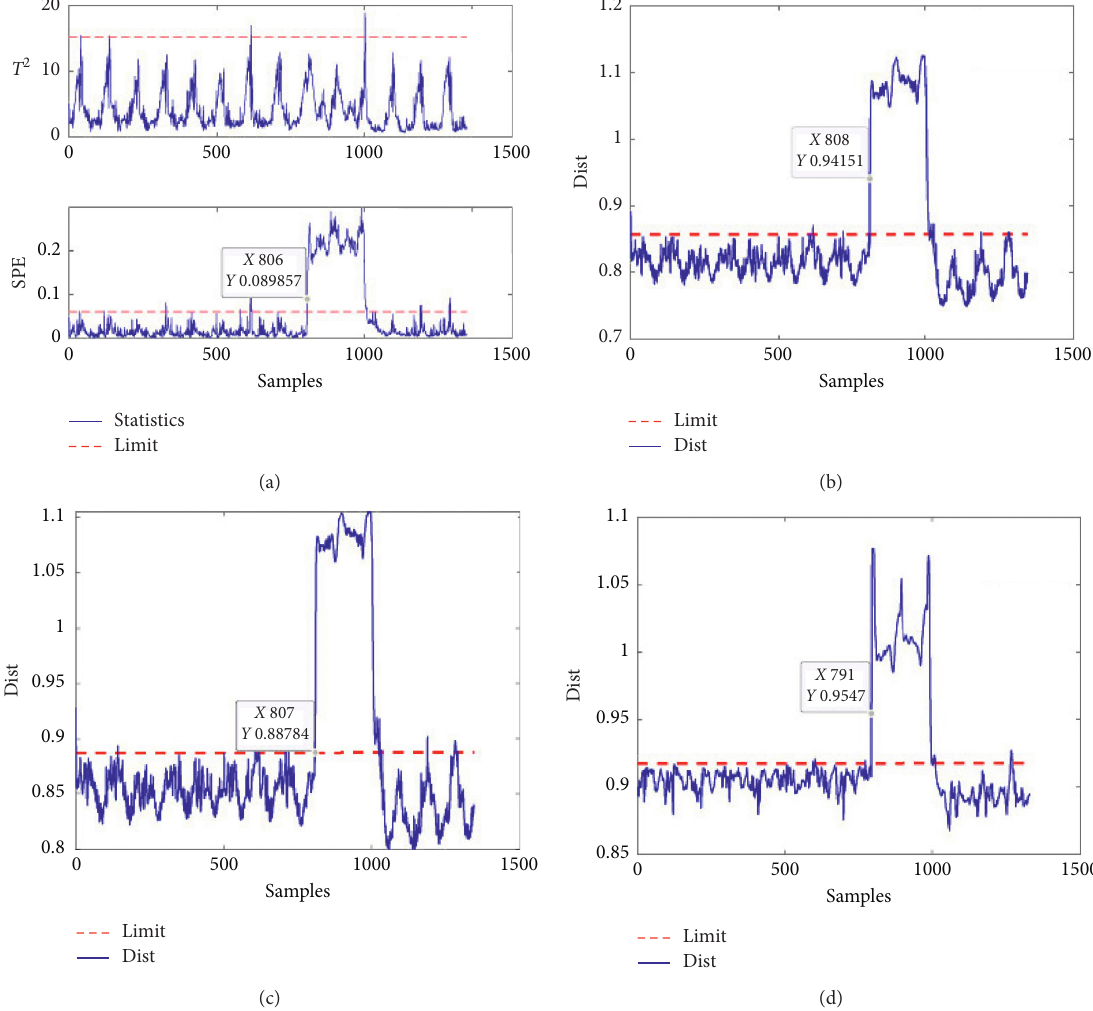
Figure 8: Monitoring results for Case 1 by (a) KPCA, (b) conventional SVDD, (c) LDR-wSVDD, and (d)